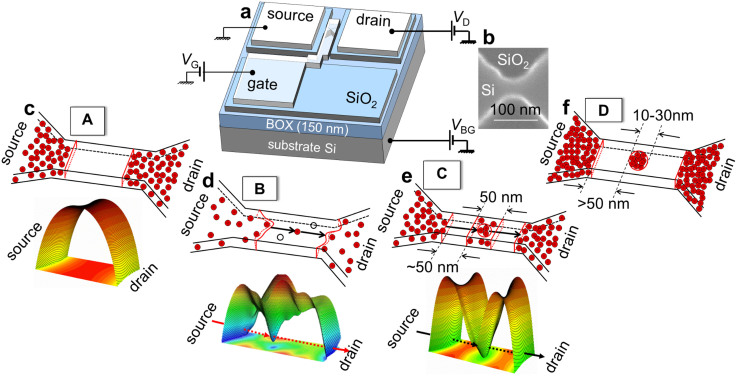
Nanoscale silicon-on-insulator field-effect transistors with different channel-doping profiles.(a), SOI-FET device structure and measurement setup. (b), An SEM image of a typical sub-100-nm channel region before doping. (c–f), Illustrations of possible dopant arrangements and expected potentials landscapes for transistors with: nominally non-doped channel (device A) (c), randomly-doped channel with ND ≅ 1 × 1018 cm−3 (device B) (d), selectively-slit-doped channel with intermediate doping concentration, ND ≅ 5 × 1018 cm−3 (device C) (e), and selectively-doped channel within a circular area, with high doping concentration, ND > 1 × 1019 cm−3 (device D) (f).